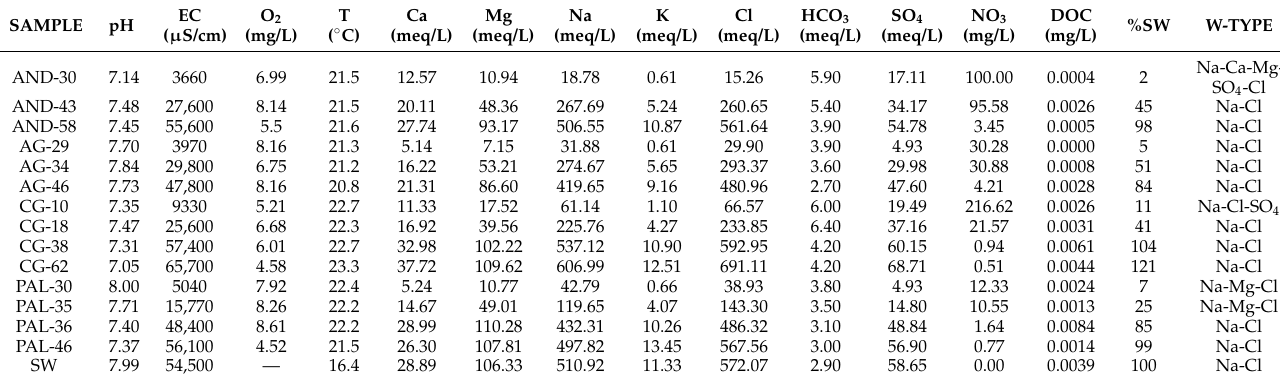
Table 1. Results of chemical analyses of water samples in meq/L. Location of sampling points in Figure 1A. (SW—seawater, EC—electrical conductivity, %SW—seawater percentage, W-TYPE— hydrochemical facies/water